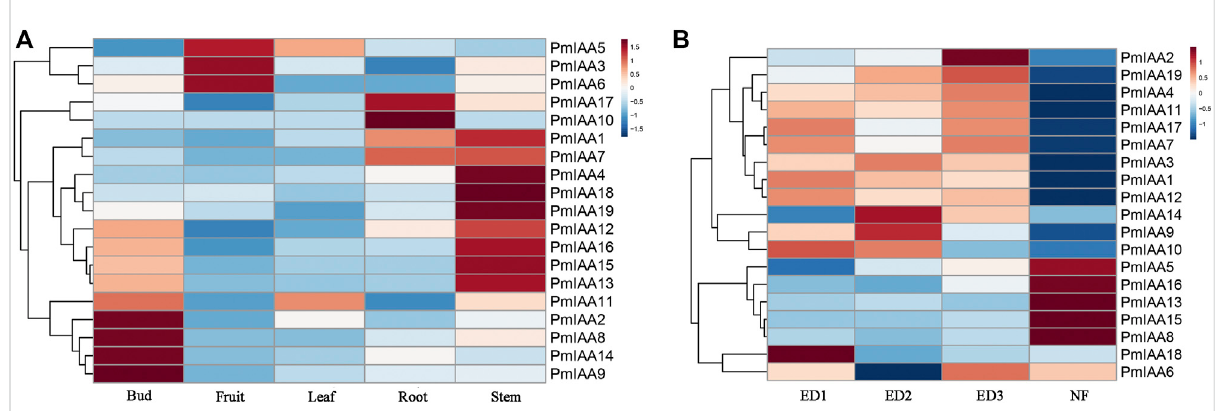
FIGURE 5 Expression pattern analysis of PmIAAs during fi ve organs and fl oral bud development (A) The gene expression pattern of PmIAA genes in root, stem, leaf, fl oral bud, and fruit tissues (B) Expression pattern of PmIAA genes during fl oral bud fl ush. Expression trends of PmIAA in the dormancy release of fl oral bud. ED one and ED two represent different degrees of endodormancy, ED three represents eco-dormancy, and NF represents fl ower bud